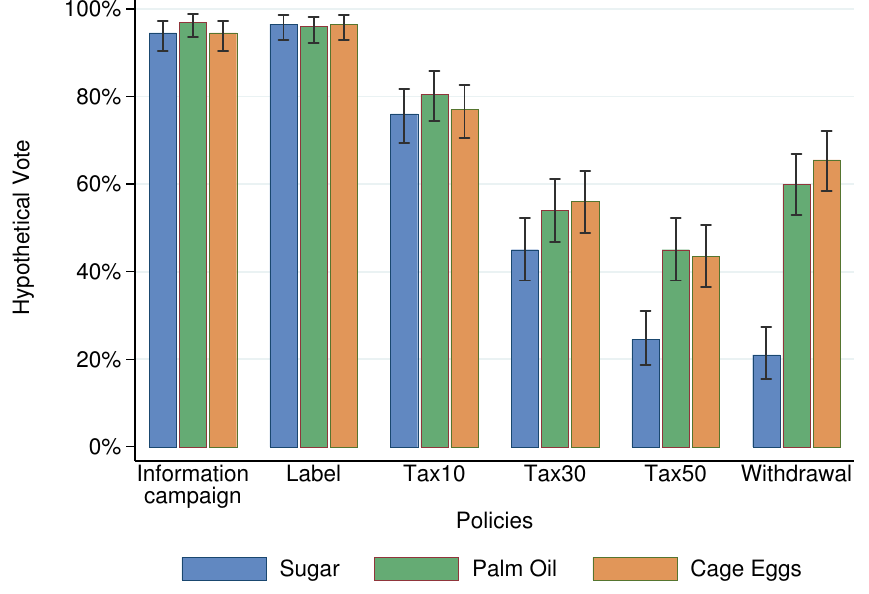
Figure 2. Reported policy acceptability: averages and 95% confidence intervals (spikes).